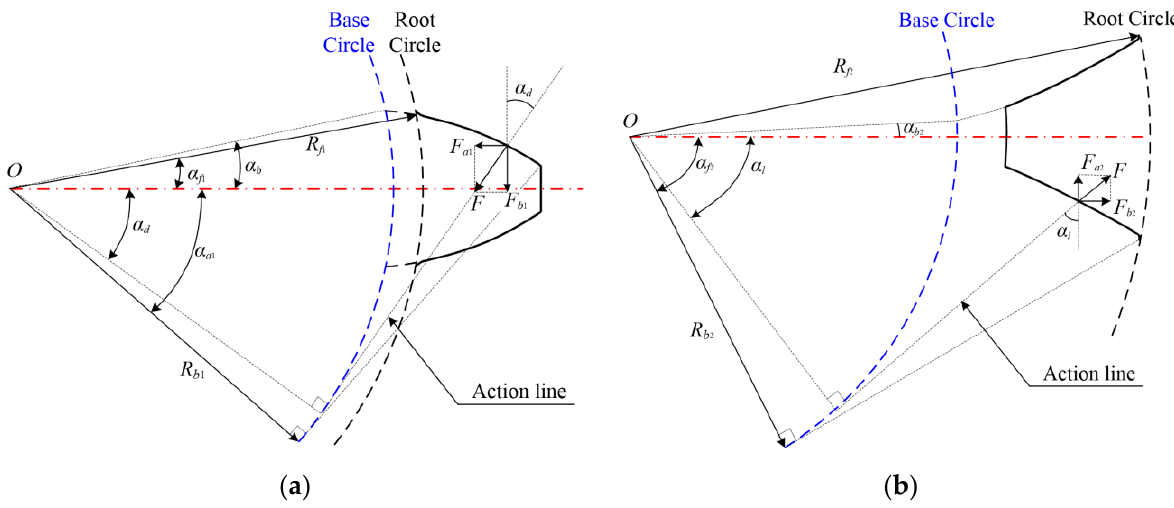
Figure 11. ( a ) The involute flexible gear tooth; ( b ) the involute rigid gear tooth.